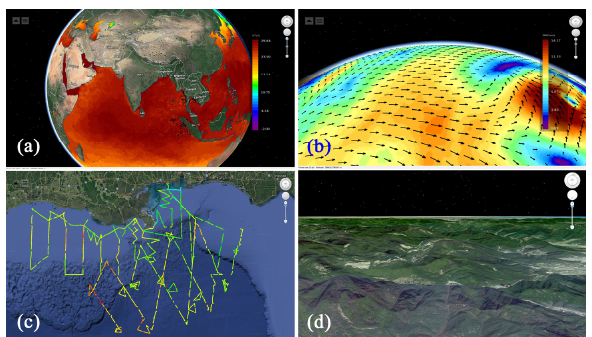
Figure 4. Various spatial data are displayed on the virtual globe, (a) satellite-derived SST product; (b) satellite-derived SSW product; (c) in situ data of salinity; (d) satellite imagery and DEM